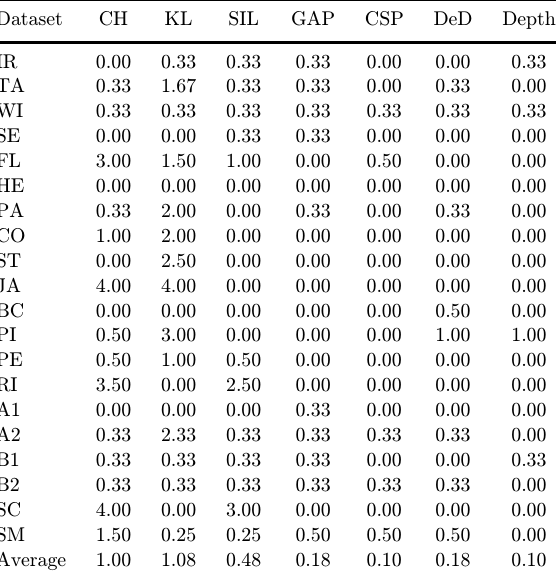
Table 3. Relative errors of the estimation of the number of clusters in relation to the known number of classes. Dataset